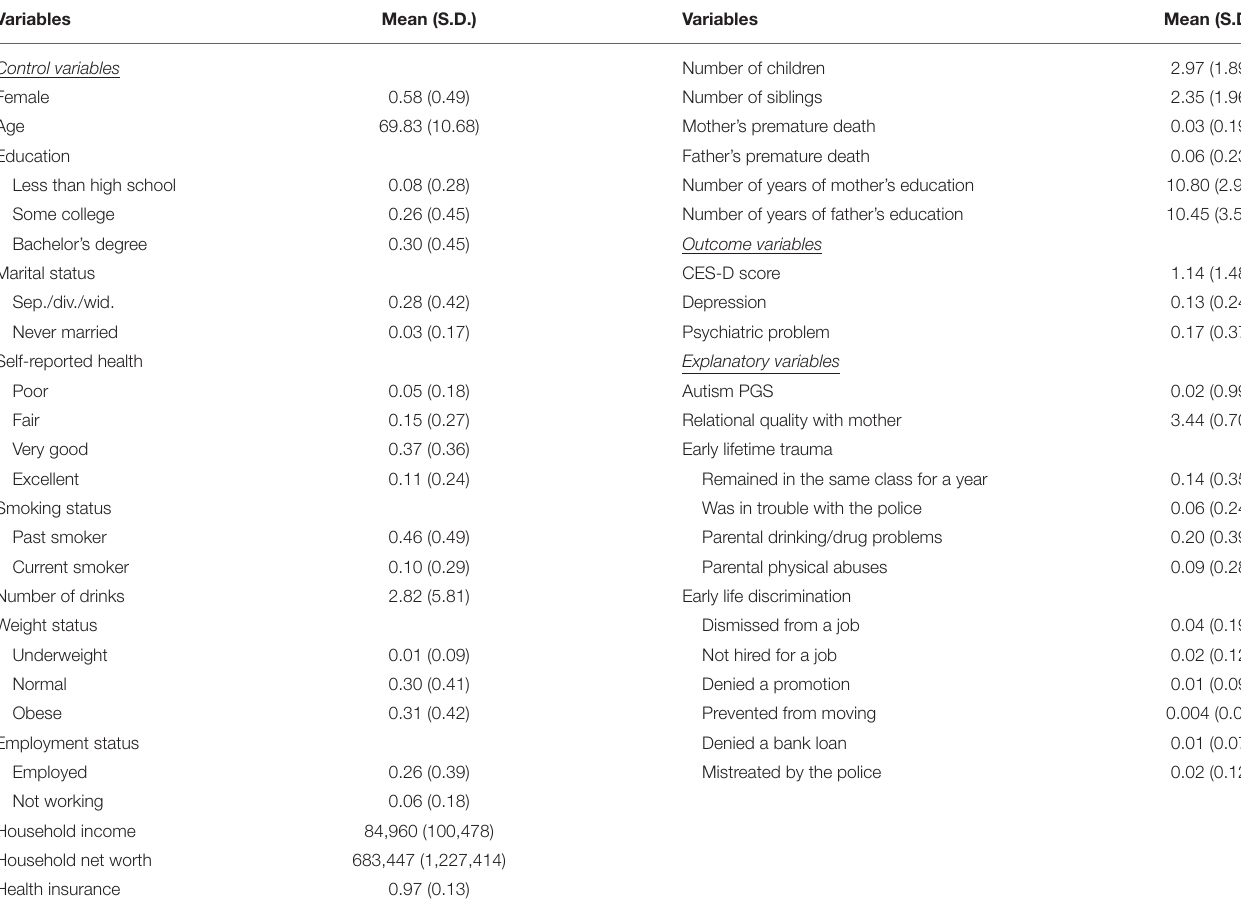
TABLE 1 | Sample characteristics, 2008–2016